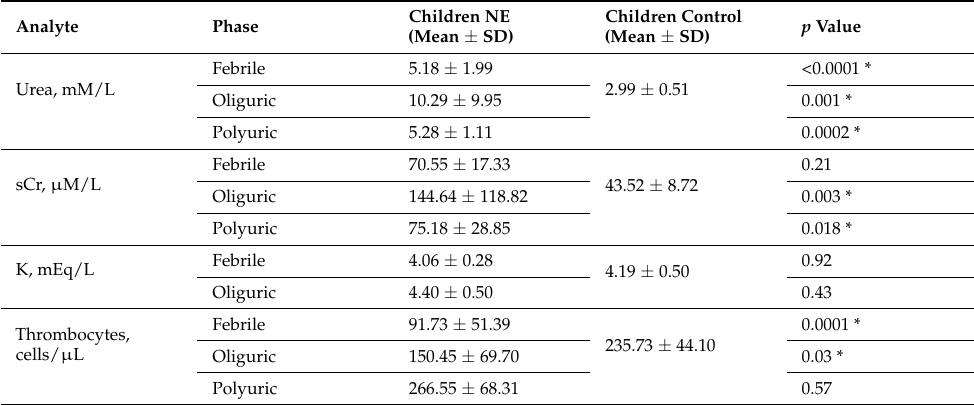
Table 4. Clinical laboratory testing results in pediatric NE patients and